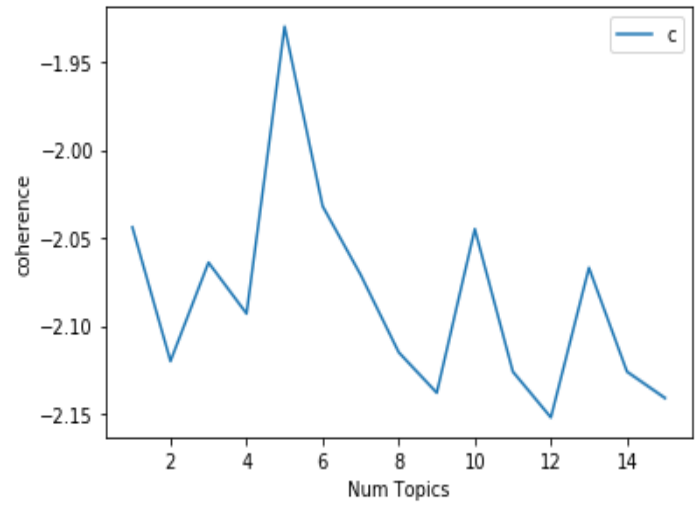
Figure 5. Consistency score of the LDA model.